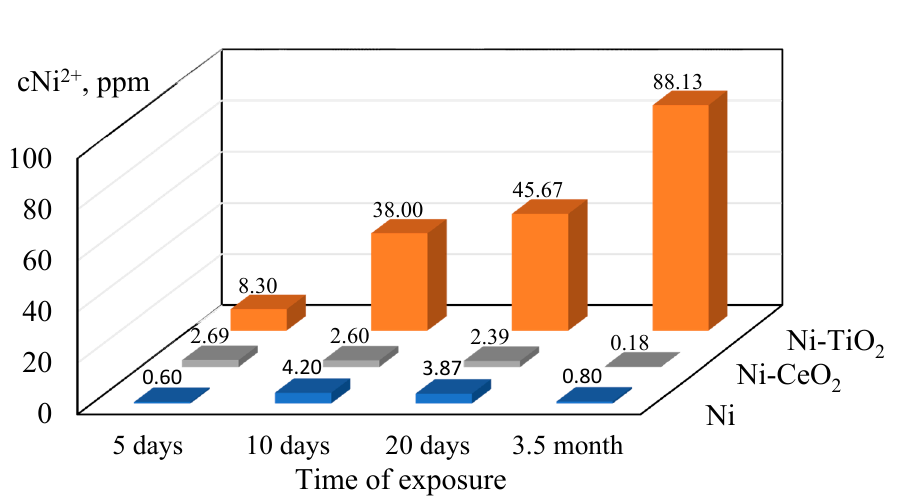
Figure 9. Concentration of nickel ions released into the 0.5 M NaCl solution during exposure for 3.5 months. Table 8. pH of 0.5 M NaCl solution * during 3.5 months of immersion of Ni, Ni-TiO 2 , and Ni-CeO 2 . Time of